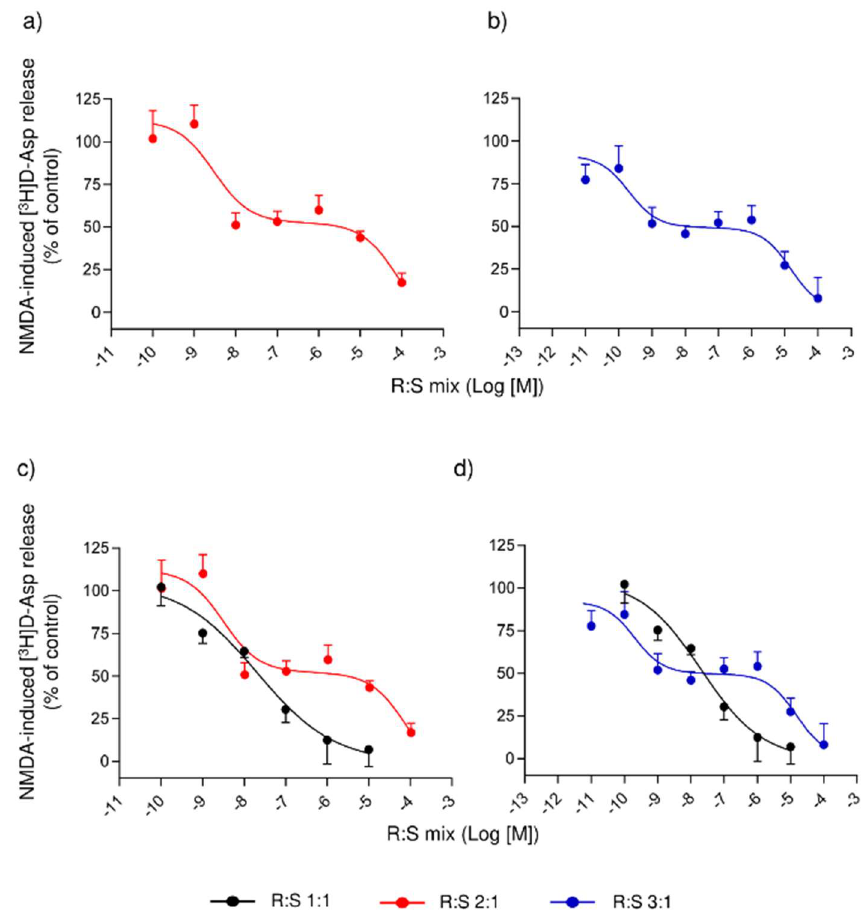
Figure 2. Concentration–response (log[M]) curves of non-racemic ( a ) 2:1 or ( b ) 3:1 R- over S- dimiracetam mixtures (R:S 2:1 and R:S 3:1) on the release of [ 3 H]D-Asp induced by NMDA in rat spinal cord synaptosomes in superfusion. ( c , d ) Comparison of the R:S 2:1 and 3:1 mixture curves to dimiracetam. Synaptosomes were labeled with the radioactive tracer, layered on microporous filters, and superfused as described in the Materials and Methods section. Results are expressed as percent of control conditions (NMDA-induced [ 3 H]D-Asp release reported as 100% response).. Data are means ± S.E.M. of 3–9 experiments run triplicate (three superfusion units for each experimental condition).